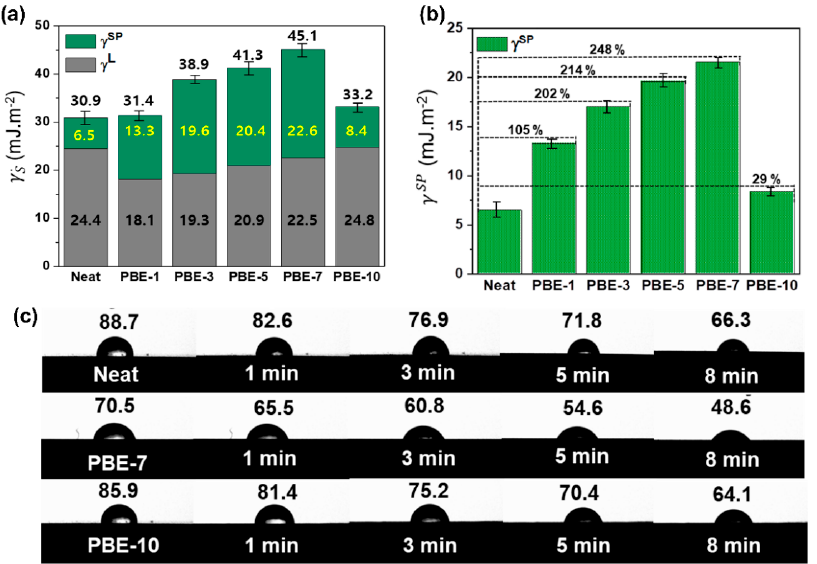
Figure 5. Interfacial properties of the BNNS/epoxy nanocomposites: ( a ) surface free energy, ( b ) spe- cific polar component, and ( c ) optical images of the contact angles of distilled water over time.